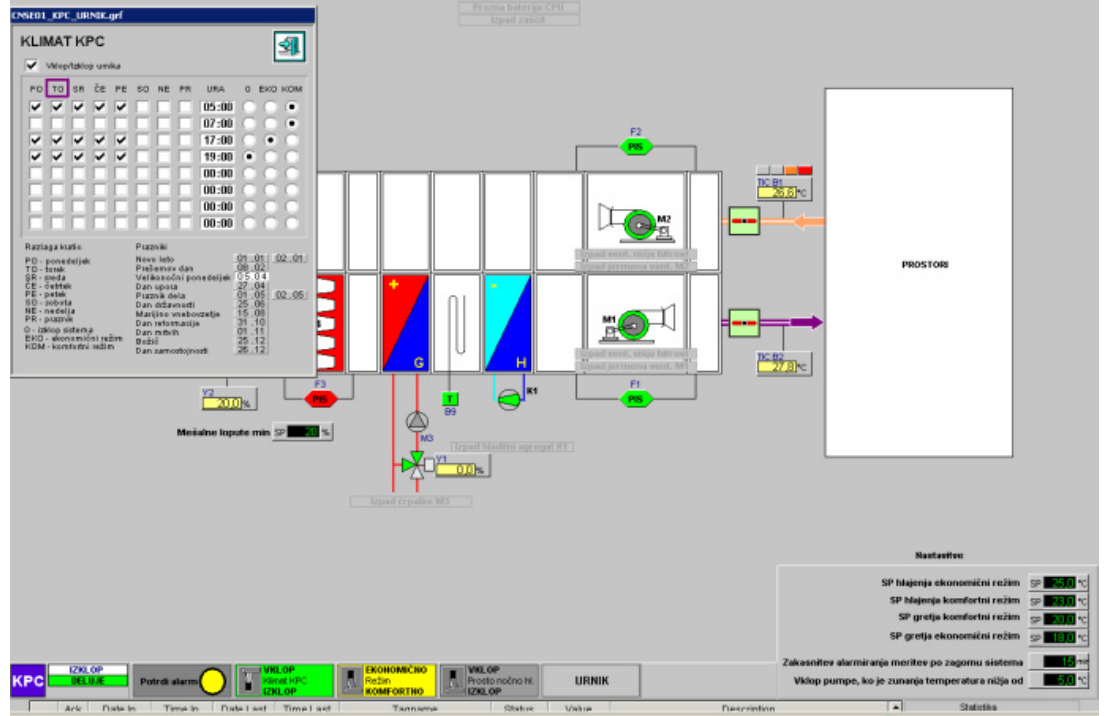
Figure 3. SCADA Real-time information about climate control in graphical form.